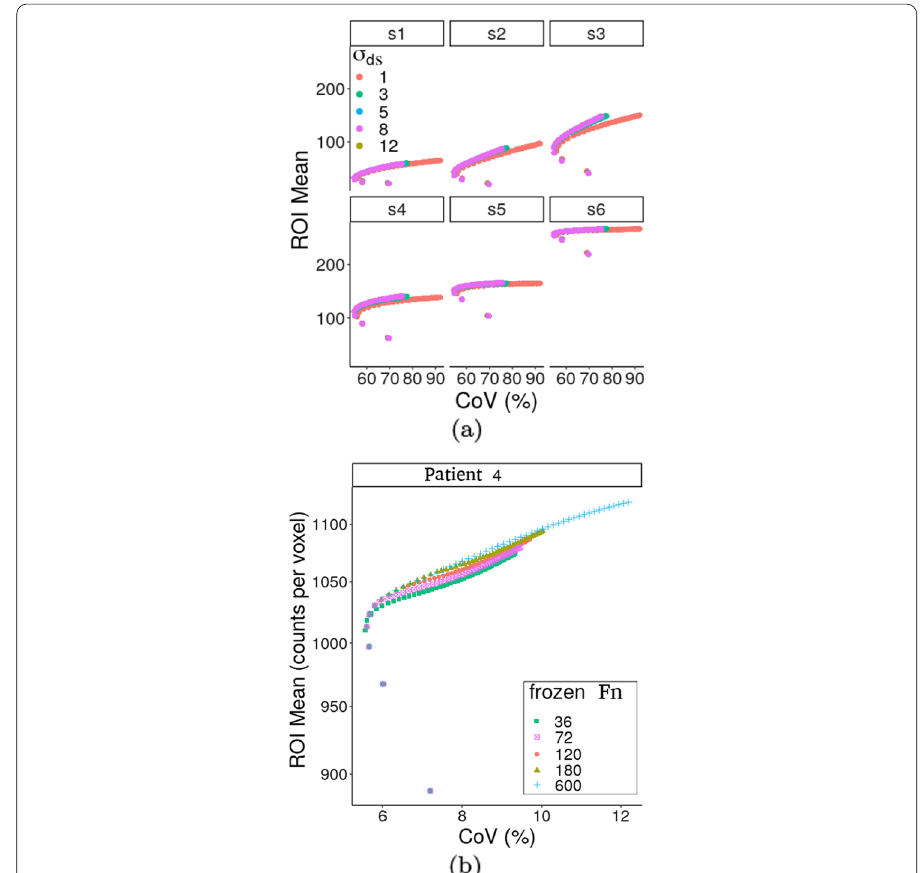
Fig. 2 Example of parameter optimisation for the FHKEM. a shows the trade‑off between ROI mean (kBq/ml) and CoV for the parameter σ ds ; b shows the trade‑off between ROI mean and CoV for the iteration where the kernel is frozen, for patient